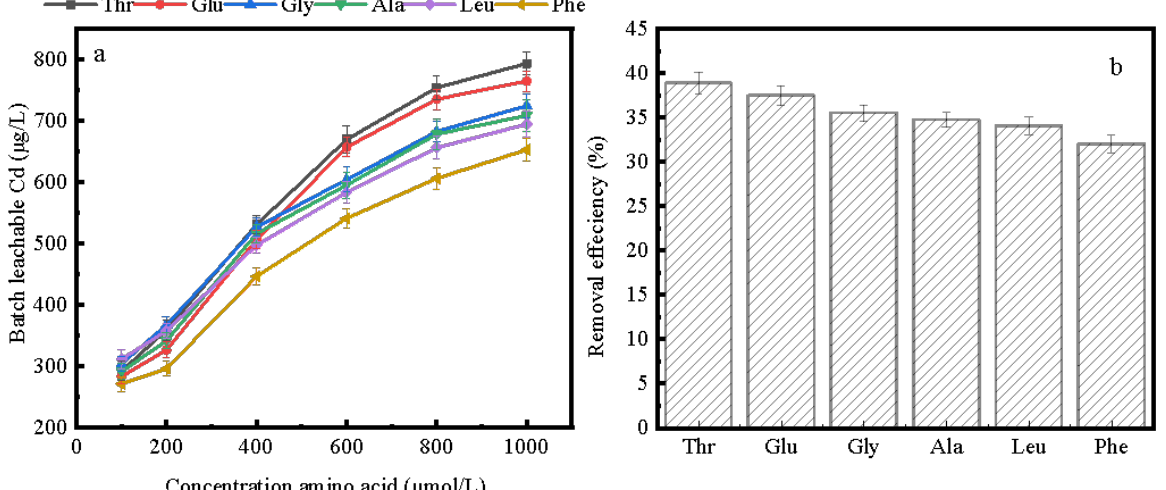
Figure 7. ( a ) Cd extraction and ( b ) the removal efficiency of Cd from contaminated soil by using the studied amino acids.